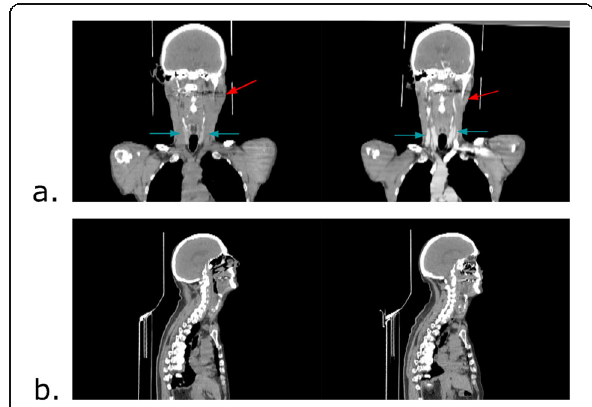
Fig. 2 Intra-individual differences that can be found in CT images acquired at different time points. Left: pre-treatment CT. Right: post- treatment CT. a Red arrow: changes of patient anatomy after the treatment. Blue arrow: intensity differences due to the injection of a contrast agent in the post-treatment CT (right). b Differences in the position of the patient between pre- and post-treatment CT. Here, the inclination of the head has